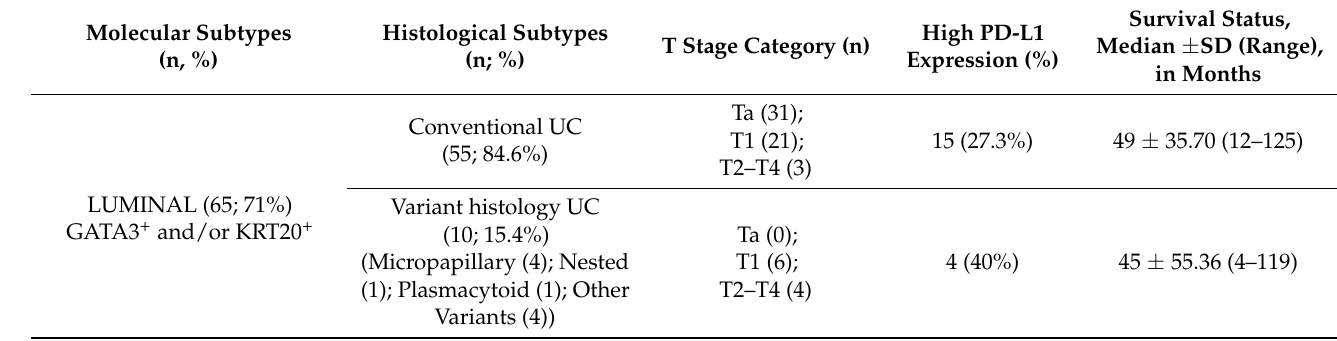
Figure 5. The three identified molecular subtypes were stratified by PD-L1 expression. Receiving operating characteristics yielded an AUC of 0.774 ( p < 0.001) for the optimal cutoff point of PD-L1 expression ( A ), which illustrated survival differences in our study series ( B ). The heatmap shows the expression of the four genes stratified by high vs. low PD-L1 expression ( C ). The enclosed histograms depict differences between high vs. low PD-L1 expression according to molecular subtypes ( D ) and stage category ( E ).